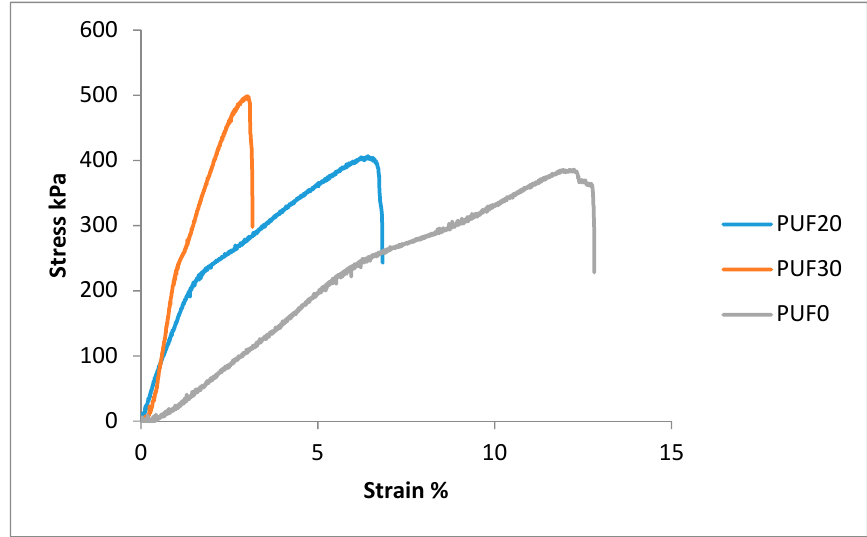
Figure 4. Tensile stress–strain relation for PUF.